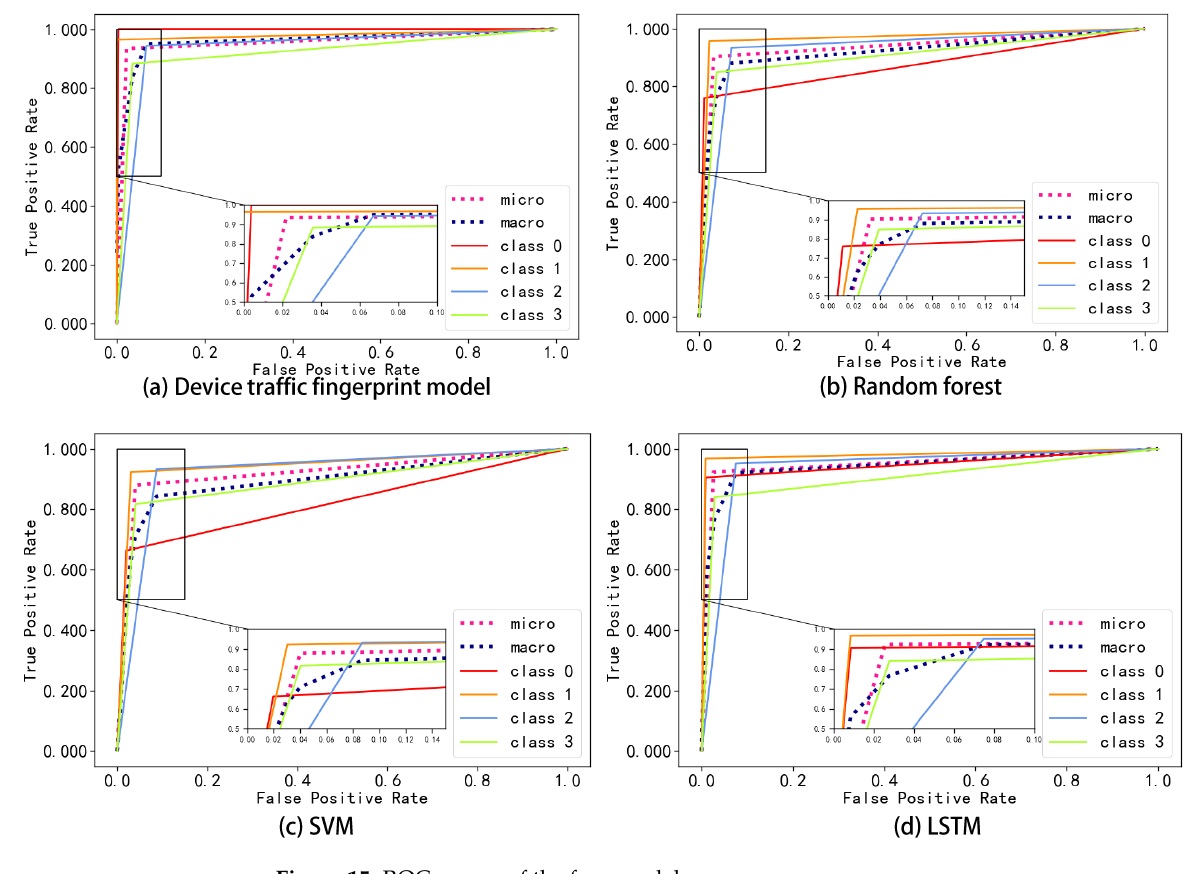
Figure 15. ROC curves of the four models.